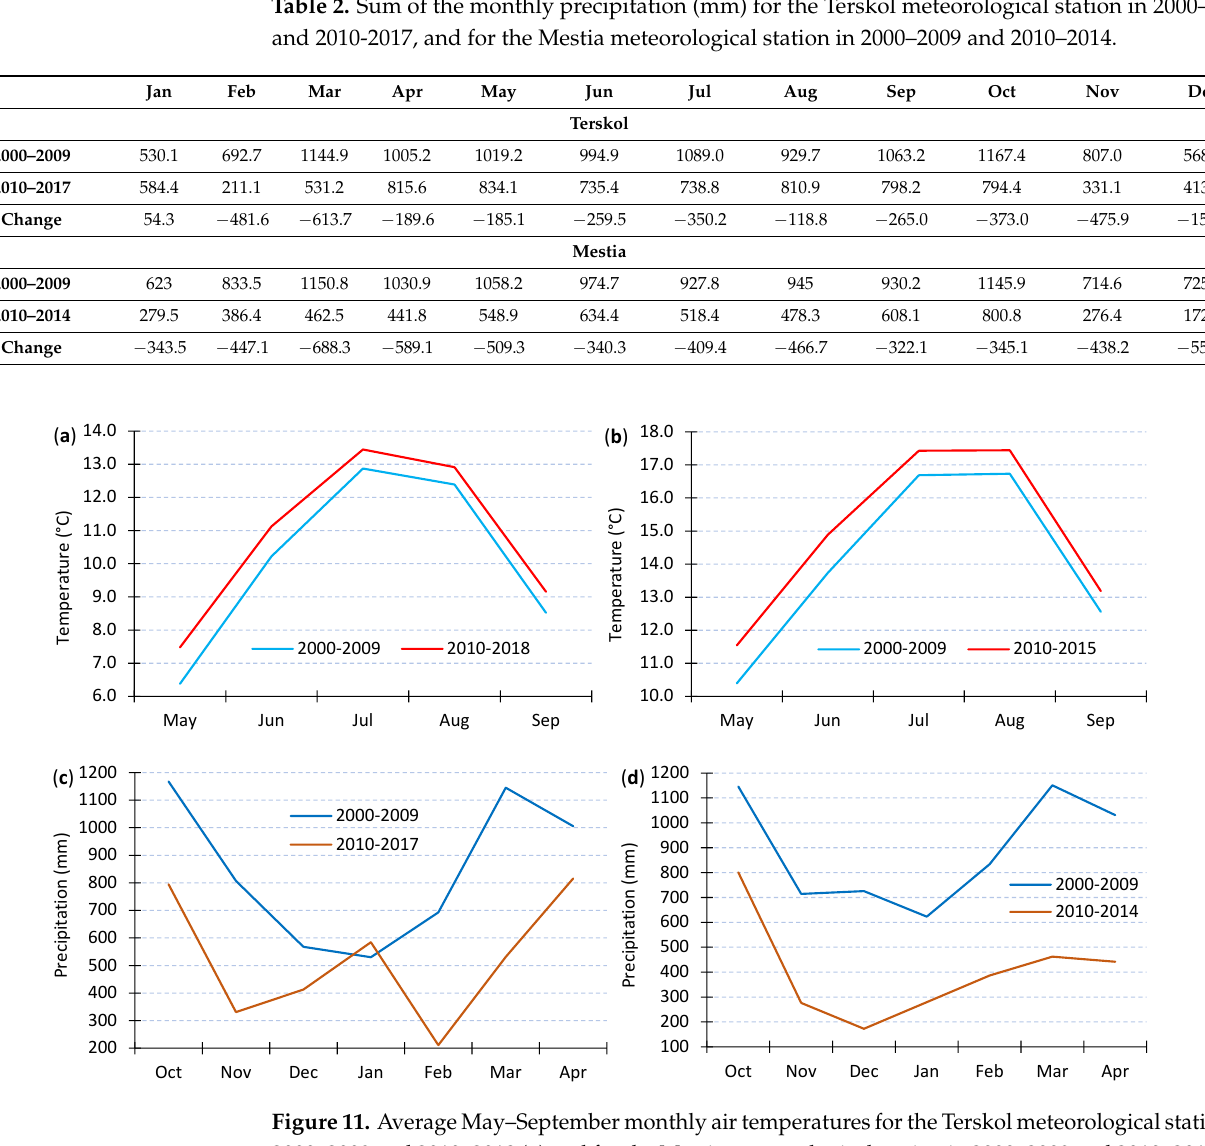
Table 2. Sum of the monthly precipitation (mm) for the Terskol meteorological station in 2000–2009